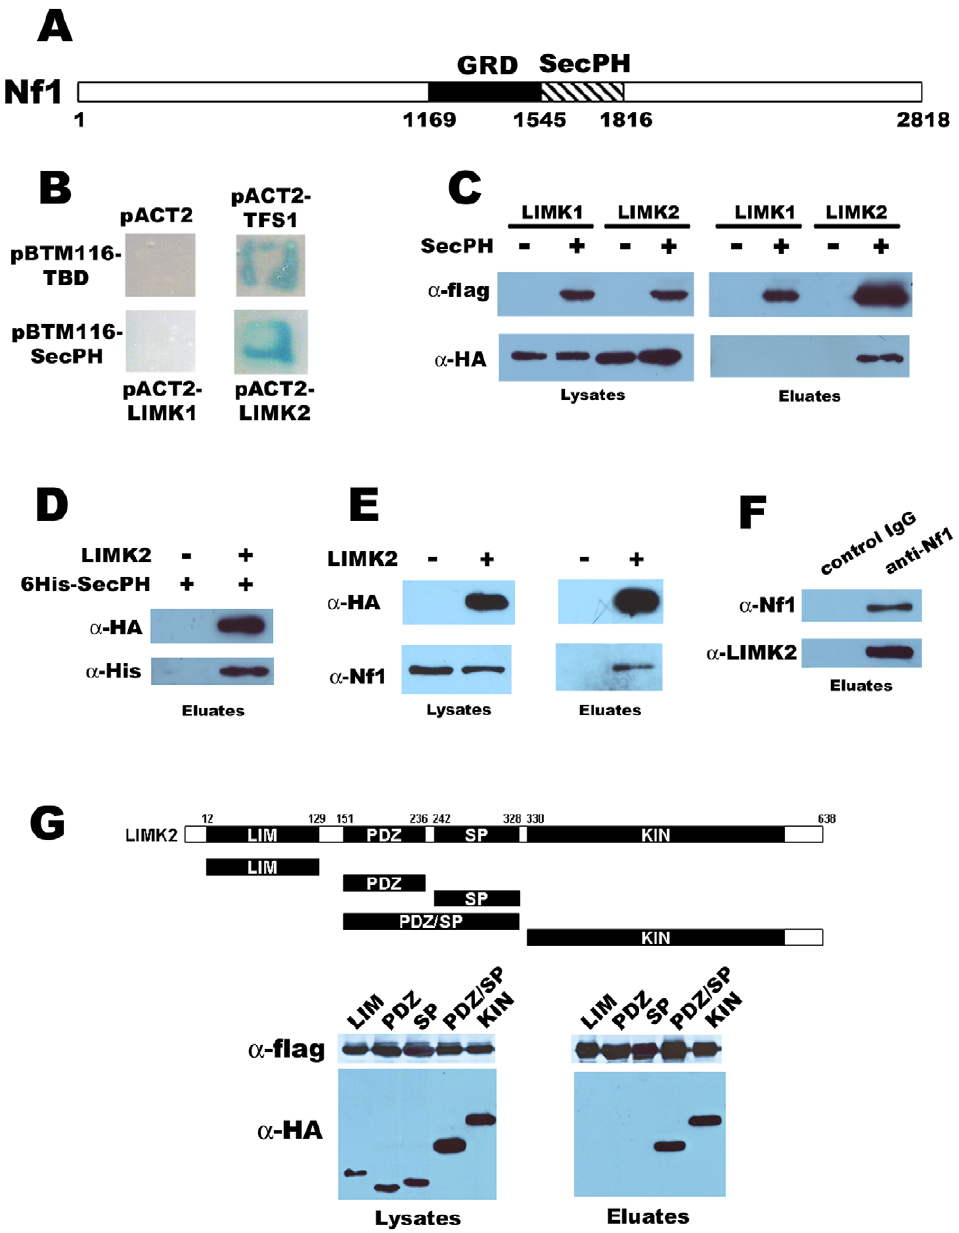
Figure 1. Interaction between LIMK2 and the SecPH domain of Nf1. A. Diagram of Nf1. GRD (GAP related domain) responsible for the main known function of Nf1 is depicted as well as SecPH, the region used for the two-hybrid screening. B. Interaction revealed by the two-hybrid screening. L40 cells transformed with pBTM116-TBD were mated with Y187 cells transformed with the empty plasmid pACT2 (as a negative control) or pACT2- TFS1 (as a positive control, as demonstrated by [32]). L40 cells transformed with pBTM116-SecPH were mated with Y187 cells transformed with pACT2-LIMK1 or pACT2-LIMK2. After mating on YPD, the resultant diploids were selected on a SD-LW medium. The interaction between the LexA fusion proteins encoded by the pACT2 plasmids and the Gal4 fusion proteins encoded by pBTM116 plasmids was tested by checking the growth of diploids on a SD-LWH media containing 3AT (1 mM) and their ability to cleave X-gal (1 mM) thereby attesting the production of b -galactosidase. C. Interaction in HEK-293 transfected cells. HEK-293 cells were cotransfected with either HA-LIMK2 or HA-LIMK1 and flag-SecPH or its parental empty plasmid (p3XFlag). Cell lysates and anti-flag immunoprecipitation eluates were analyzed by immunobloting. D. Immunoprecipitated LIMK2 interacts with recombinant 6His-SecPH. HEK-293 cells were transfected with HA-LIMK2 or its parental empty plasmid, pcDNA3. The corresponding cell lysates were immunoprecipitated with anti-HA beads. Beads were then incubated with 6His-SecPH in lysis buffer. Anti-HA immunoprecipitates were analyzed by immunobloting. E. Transfected LIMK2 interacts with endogenous Nf1. Cells were transfected with HA-LIMK2 or its parental empty plasmid, pcDNA3. Lysates and anti-HA immunoprecipitates were analyzed by immunobloting. F. Endogenous LIMK2 interacts with endogenous Nf1 Anti-Nf1 immunoprecipitates from HEK-293 were analyzed by immunobloting. G. Domains of LIMK2 involved in its interaction with SecPH . Top. Schematic diagram of LIMK2 and its various fragments designed for this study. Bottom. Cells were cotransfected with SecPH and one of the domains of LIMK2. Lysates and anti-flag immunoprecipitates were analyzed by immunobloting.